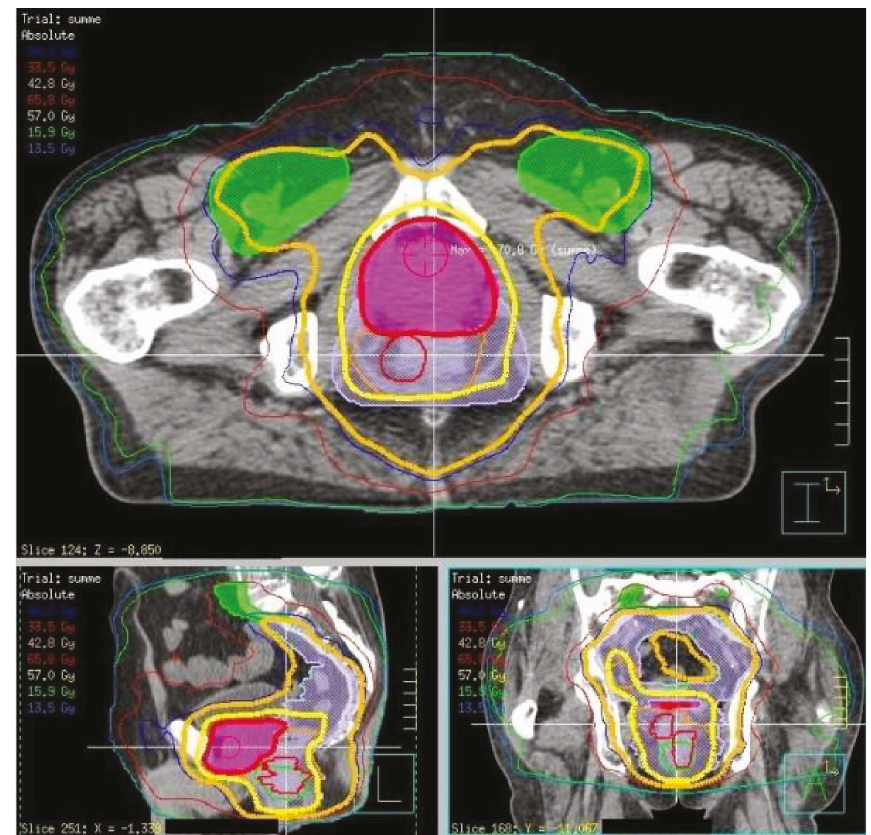
Figure 1: Dose distribution in the sum plan at the level of both primary